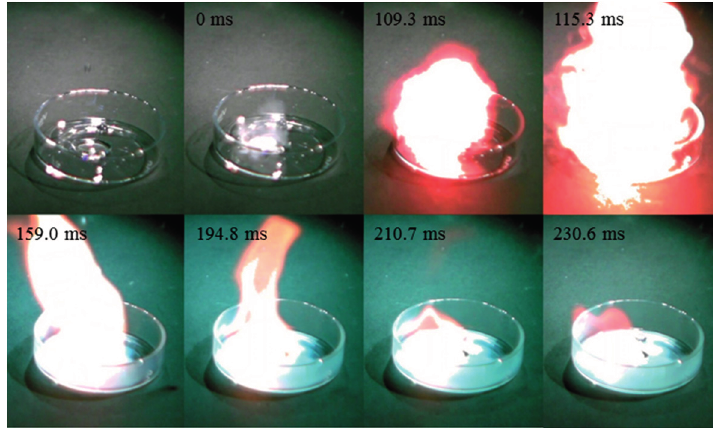
Figure 6. ID time photographs of the mixture hypergolic chemicals with [TMH] + [I] − and HOCH 2 CH 2 NHNH 2 using H 2 O 2 .